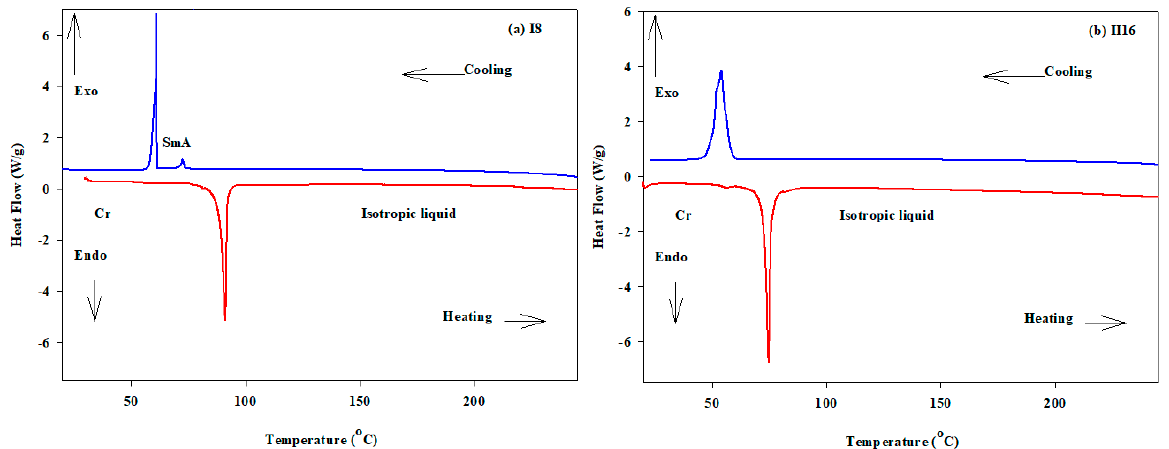
Figure 1. Differential scanning calorimetry (DSC) thermograms of I 8 and II 16 derivatives upon the second heating/cooling scan with a rate of 10 °C /min.